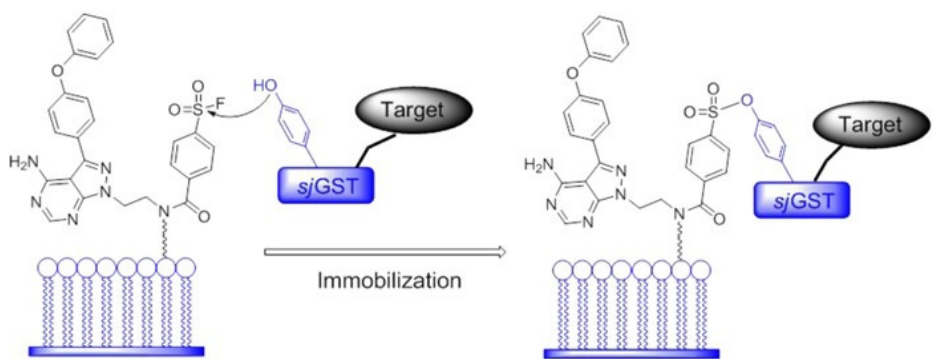
Figure 6. Scheme of site-selective covalent immobilization of the recombinant protein kinases ITK and EGFR with fused sj GST tags through irreversible and specific covalent modification of the tyrosine 111 residue of the sj GST tag. Immobilization involved the use of small-molecule pyrimidine-based probes with a reactive group of sulfonyl fluoride. Reprinted with permission from [129]. Copyright (2012) American Chemical Society.